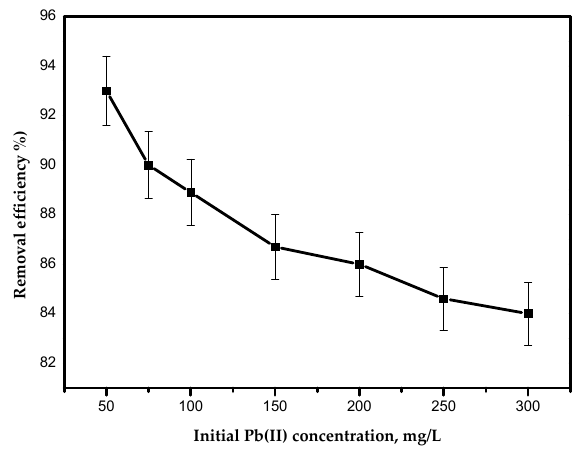
Figure 9. Effect of the initial concentration of Pb(II) ions on the removal efficiency.